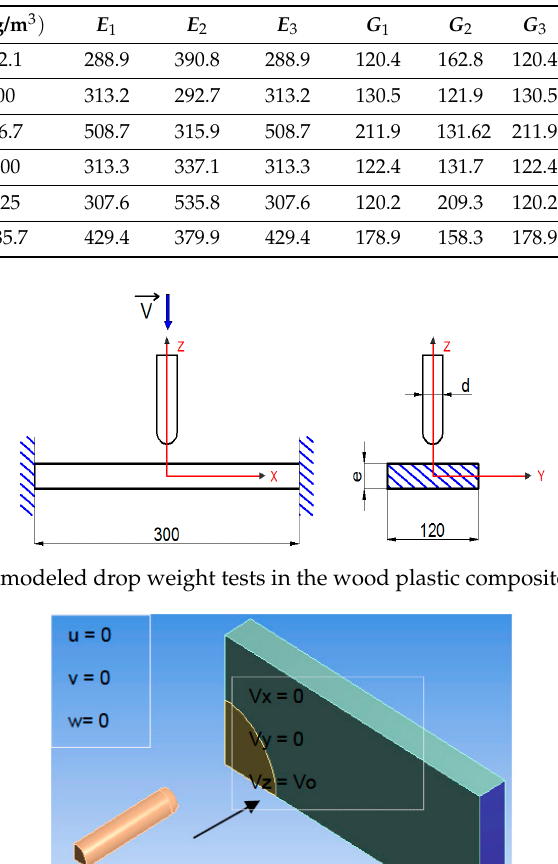
Figure 2. Applied initial and boundary conditions.